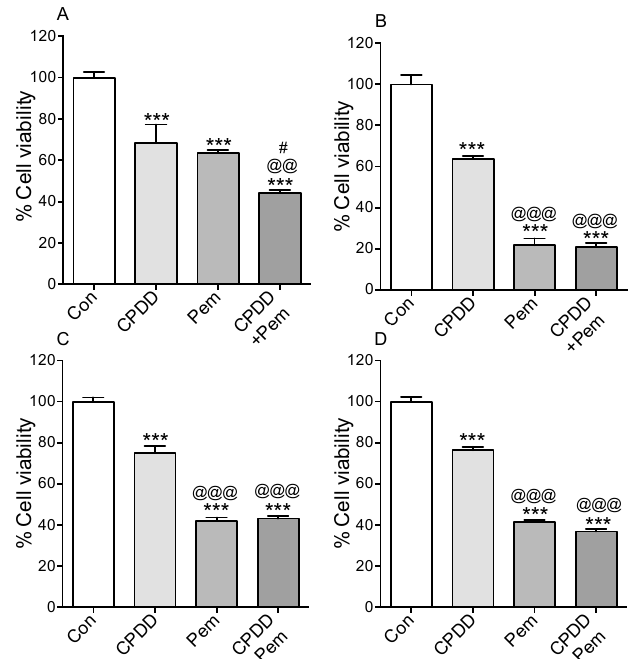
Figure 1. Mean values of cell viability ± SEM without or with treatments (CPDD, Pem, or CPDD+Pem) expressed as % of Controls (cells with 10% FBS-RPMI). ( A ) MeT-5A cells ( n = 13), ( B ) M14K cells ( n = 16), ( C ) MSTO cells ( n = 16), ( D ) ZL34 ( n = 15 or 16). *** p < 0.001 vs. Controls, @@ p < 0.01 and @@@ p < 0.001 vs. CPDD, # p < 0.05 vs. Pem.